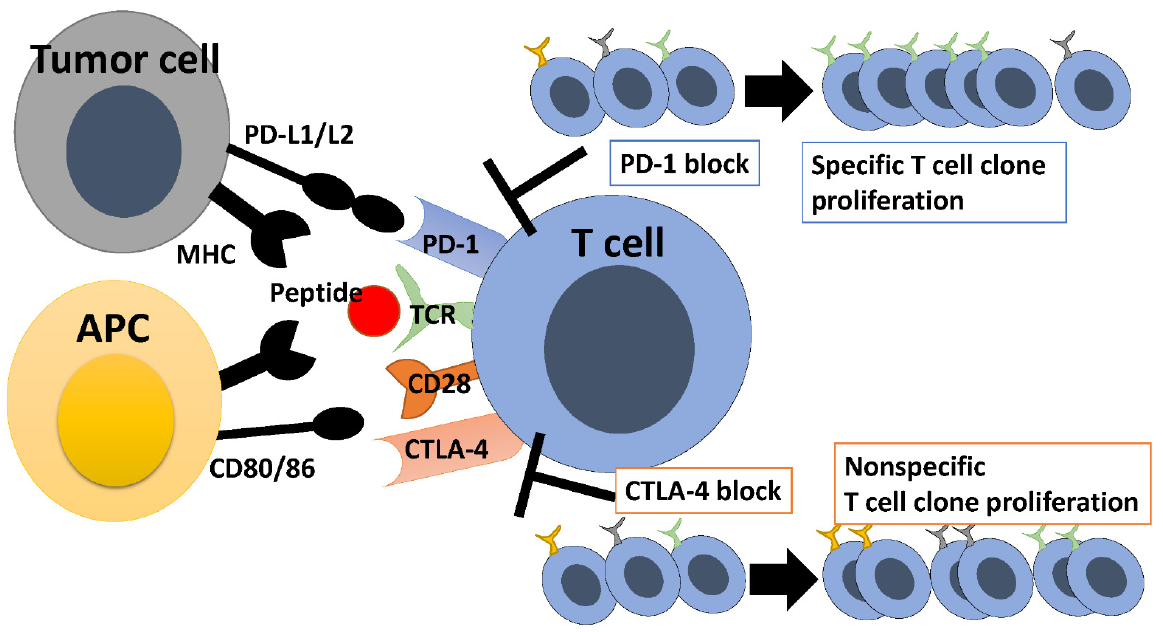
Figure 1. Repertoire changes with immune checkpoint inhibitors.